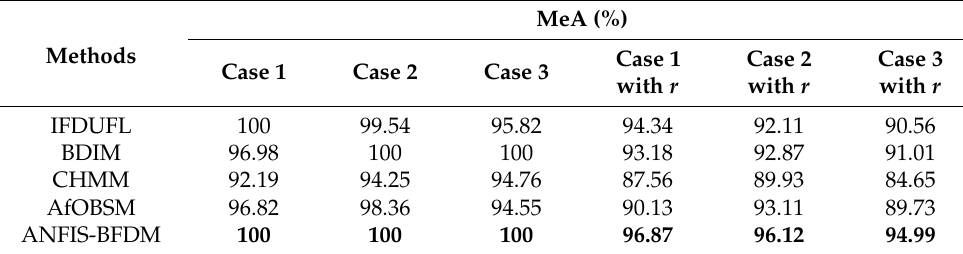
Table 6. Comparing results related to the three datasets in two cases: with/without noise r ( t